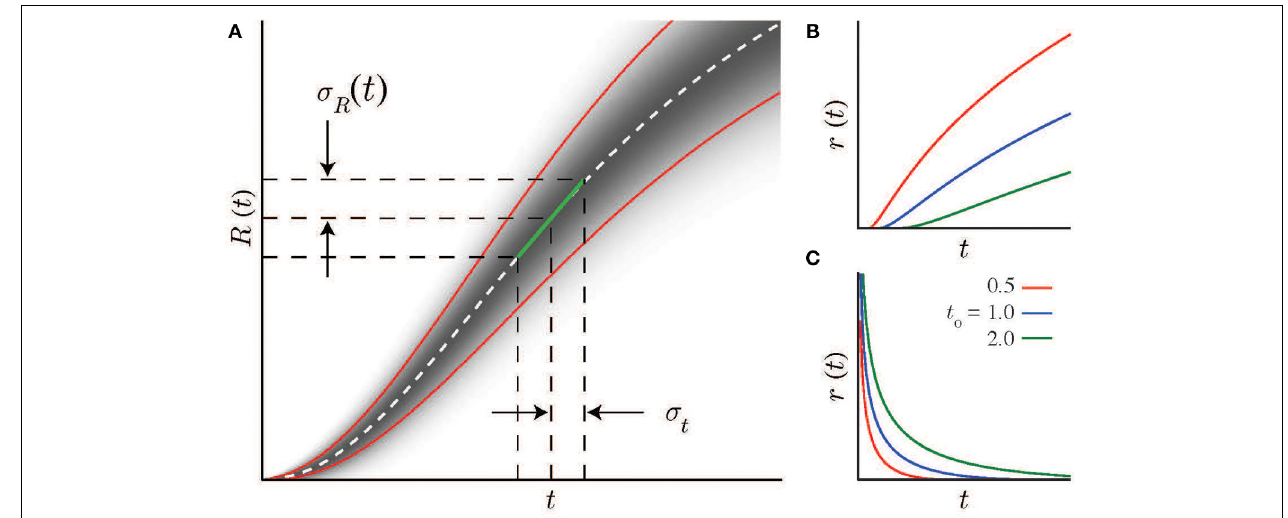
7 for the case of Poisson noise) is the firing rate curve r ( t ). Note, R (cid:2) is the slope of the linear approximation to R ( t ). (B,C) Example firing rate curves with Poisson spike statistics for different values of the integration constant t